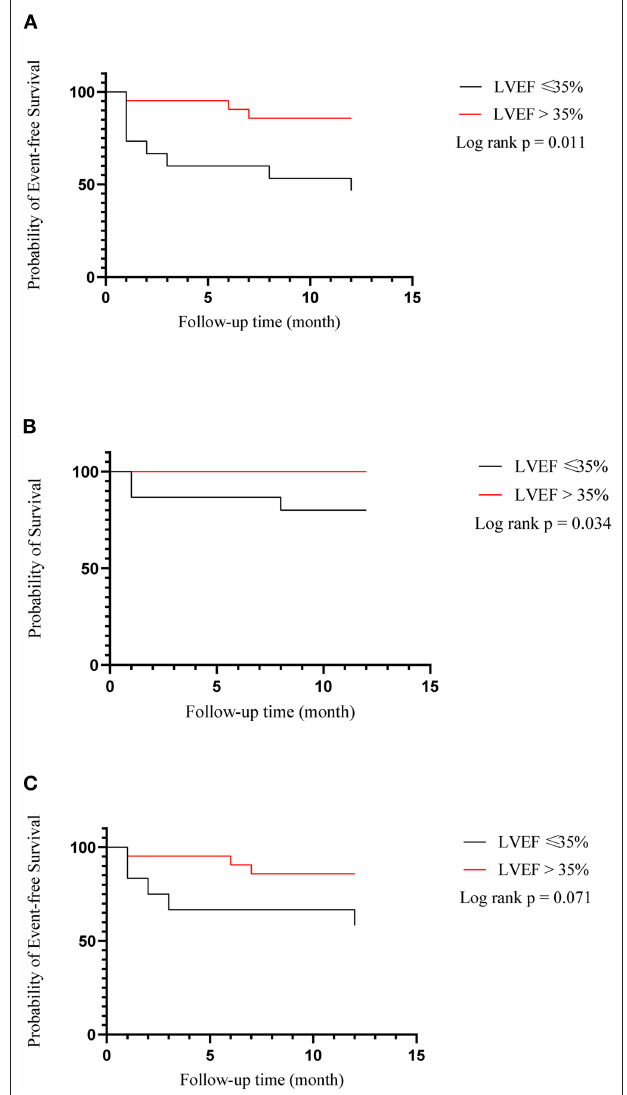
FIGURE 1 | Kaplan–meier estimates of death or hospitalization for heart failure (composite primary outcome), death from any cause and hospitalization for heart failure among all of 36 patients recruited. (A) Heart failure hospitalization or death from any cause; (B) Death from any cause; (C) Heart failure